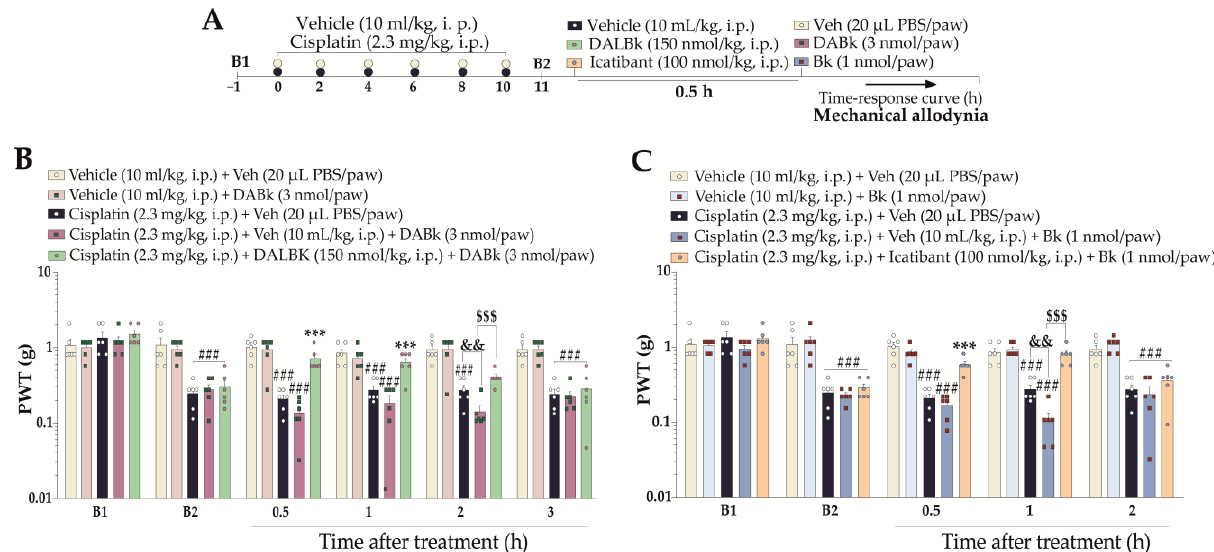
Figure 6. Kinin B 1 and B 2 receptor antagonists prevent the enhancement of B 1 and B 2 receptor agonist-induced mechanical nociception in cisplatin-treated mice. ( A ) Male Swiss mice were treated intraperitoneally (i.p.) with cisplatin (2.3 mg/kg) every 48 h for 10 days. On the 11th day after the first cisplatin injection, the animals received a single administration of DALBK (150 nmol/kg, i.p.), Icatibant (100 nmol/kg, i.p.), or vehicle (10 mL/kg, intraperitoneal, i.p.). After 0.5 h, sub-nociceptive doses of the respective agonists, i.e., DABk (3 nmol/paw, i.pl.) or Bk (1 nmol/paw, i.pl.), or vehicle (20 μL PBS/paw, intraplantar, i.pl.) were administered via the intraplantar route. PWT ( B , C ) was assessed from 0.5 h up to 3 h after the treatments. Baseline 1 (B1) values were measured before cisplatin or vehicle administration. Baseline 2 (B2) values were measured on the 11th day after the first cisplatin dose and before the treatments. The symbols on the bars indicate individual values for each animal. ### p < 0.001 vs. Veh plus Veh group. && p < 0.01 vs. cisplatin plus Veh. *** p < 0.001 vs. cisplatin plus Veh. $$$ p < 0.001 vs. cisplatin plus DABk/Bk group. Data are expressed as the mean + SEM (n = 6/group) and were analysed by two-way ANOVA followed by the Bonferroni post hoc test, except for the DABk effect on mechanical allodynia (Student’s t -test). Veh: vehicle; PBS: phosphate-buffered saline; PWT: paw withdrawal threshold.